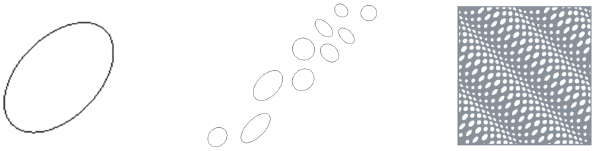
Figure 8. Evolution of the first pattern.